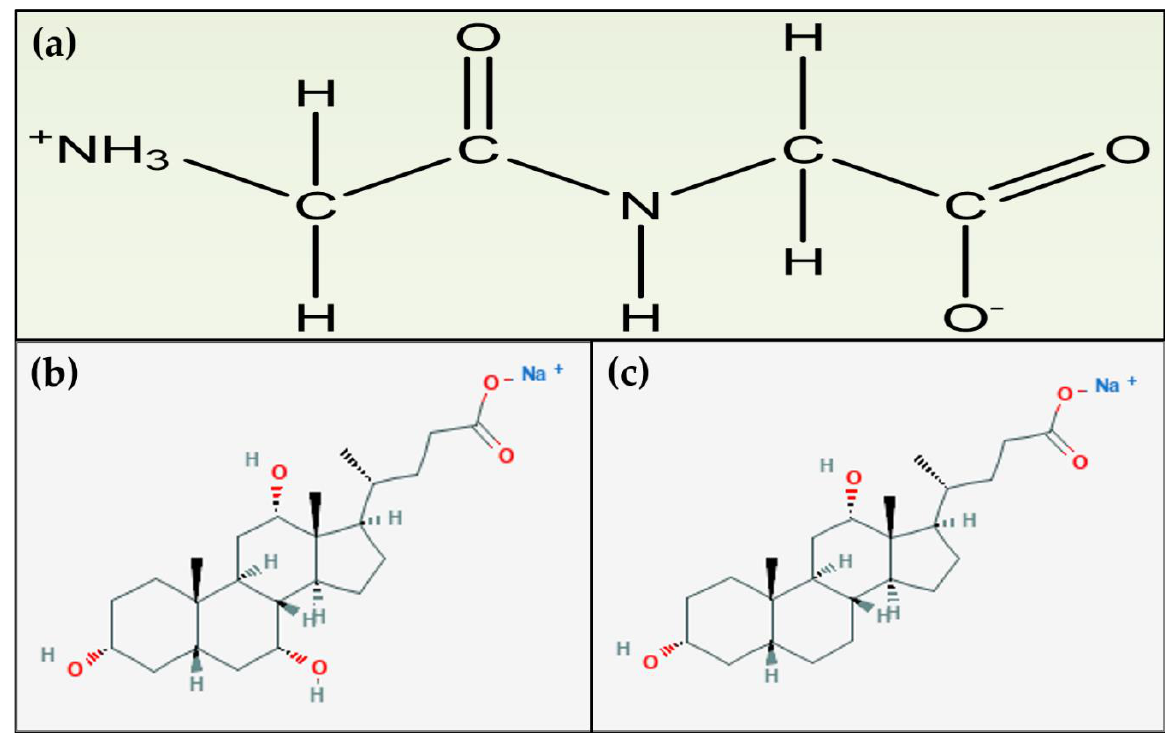
Figure 1. Molecular structure of ( a ) Zwitter ionic Glycylglycine, ( b ) sodium cholate (C 24 H 39 O 5 Na), and ( c ) sodium deoxycholate (C 24 H 39 O 4 Na).